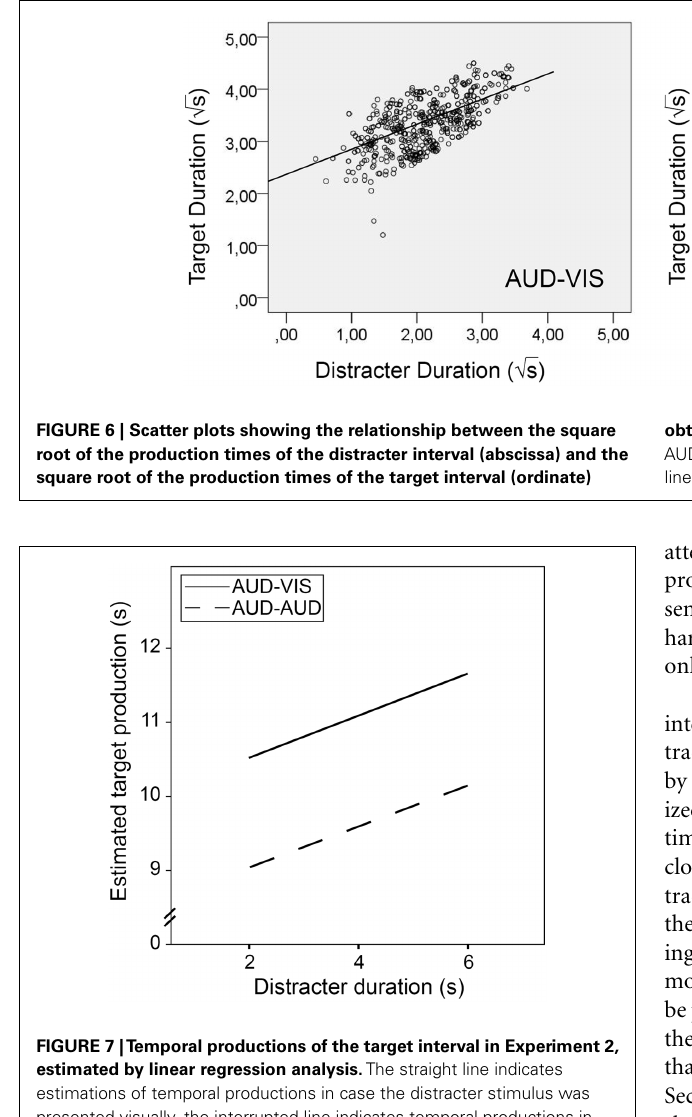
FIGURE 7 |Temporal productions of the target interval in Experiment 2, estimated by linear regression analysis. The straight line indicates estimations of temporal productions in case the distracter stimulus was presented visually, the interrupted line indicates temporal productions in case the distracter stimulus was presented auditorily. Note that temporal estimates and distracter times were displayed as untransformed values to yield better